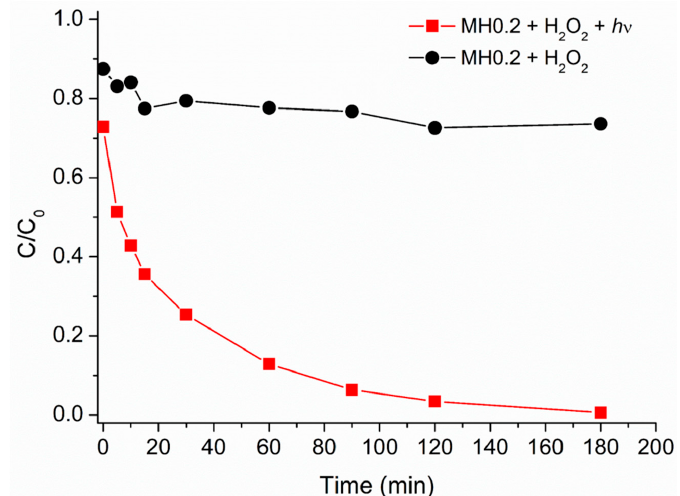
Figure 4. Caffeine relative degradation vs. irradiation time in the presence of MH0.2 (200 mg·L − 1 ) and H 2 O 2 (1.50 × 10 − 3 M). Data reported considering an initial caffeine concentration of 5 mg·L − 1 . Dark condition (black circles), light irradiation (red squares).